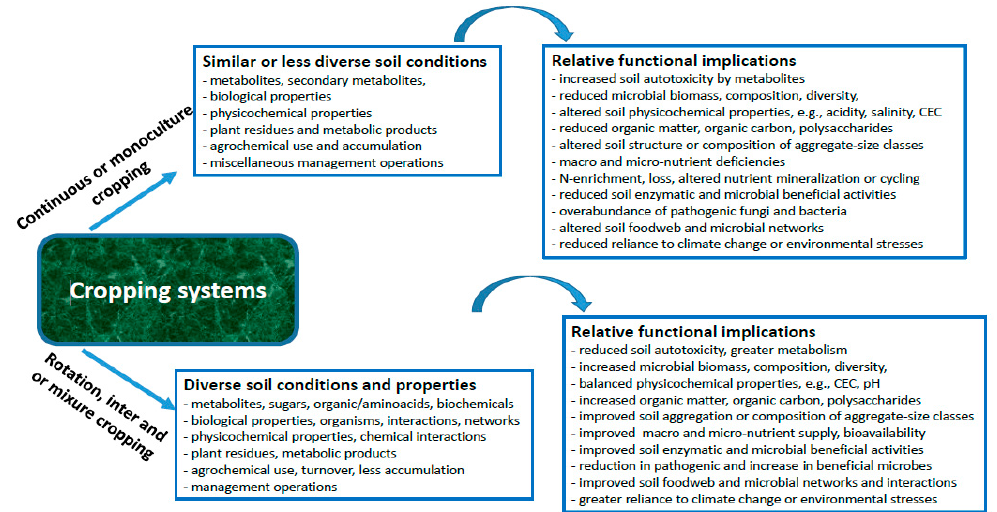
Figure 2. The summary of the comparative effects of continuous monoculture vs. alternative cropping (inter, mixture, cover-crop rotation) systems on multiple health indicators of soil health.